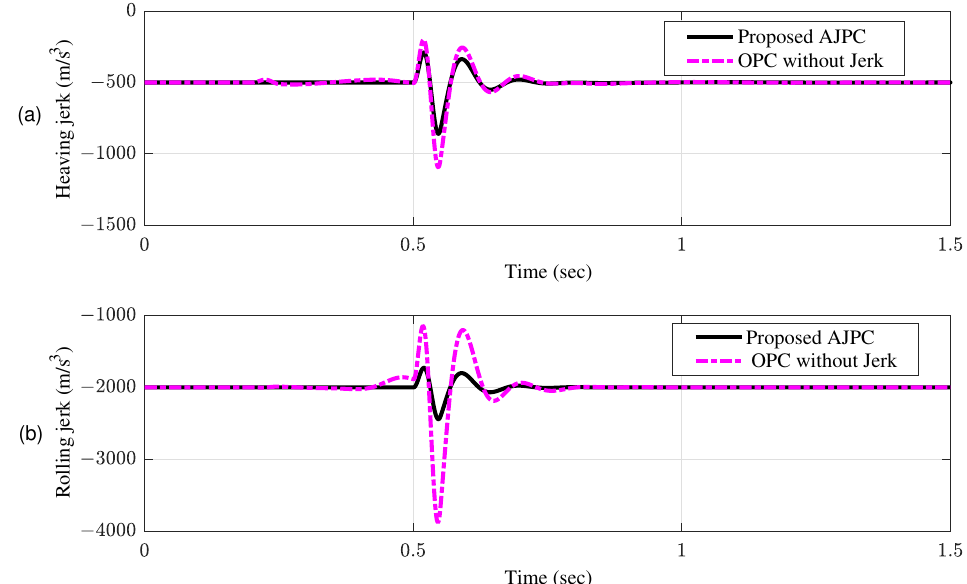
Figure 9. Time domain response of vehicle body jerk to a bump velocity input using proposed AJPC strategy and OPC strategy without jerk; ( a ) heaving jerk ( b ) rolling jerk.